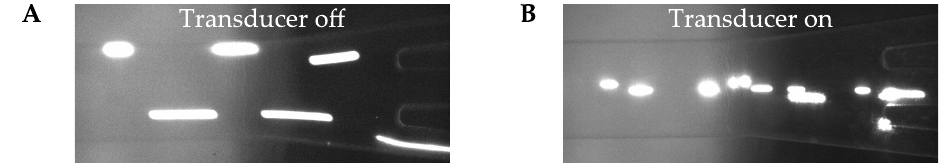
Figure 11. Images from a video recording of the downstream end of the microchannel, during an experiment to extract PS MPs from filtered seawater using acoustophoresis in co-flow operation. ( A ) The transducer is off, and the PS MPs are shown confined to the outer streams. ( B ) The transducer is actuated, which displaces the PS MPs to the center of the microchannel. Flow from the center of the microchannel is extracted from the inner exit